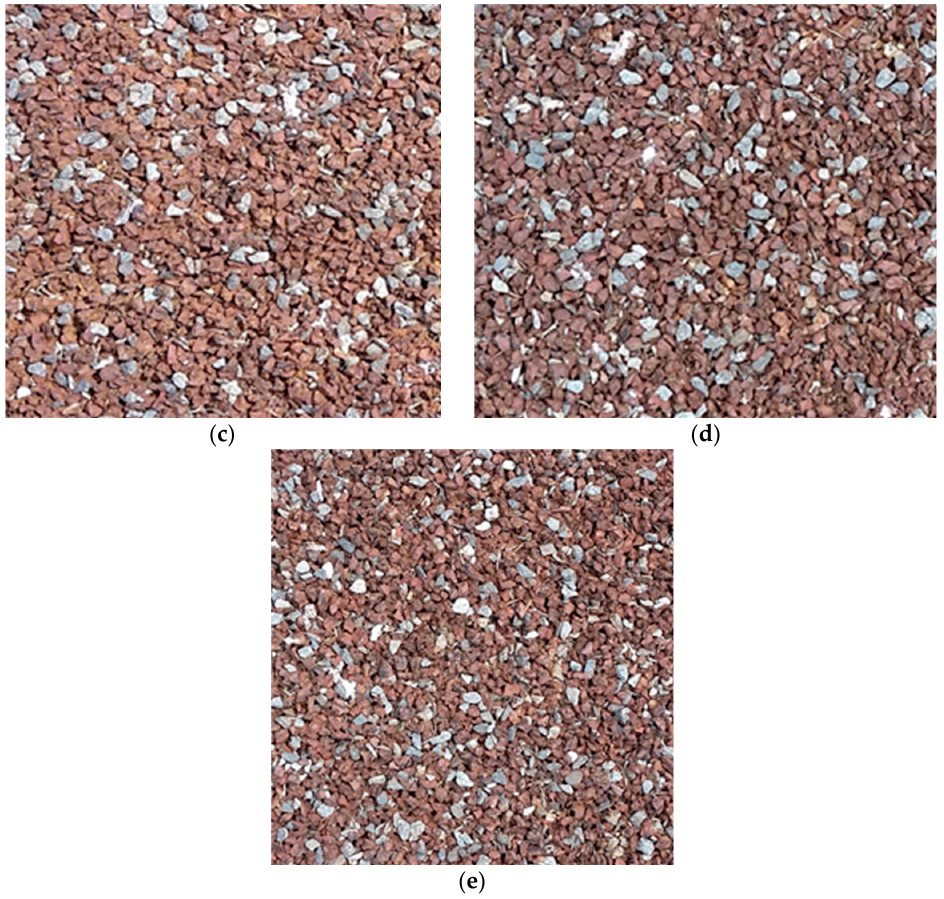
Figure 6. Images acquired with a cell phone camera of on the Porous Pave site at location 1 in ( a ), location 2 in ( b ), location 3 in ( c ), location 4 in ( d ), and on location 5 in ( e ).